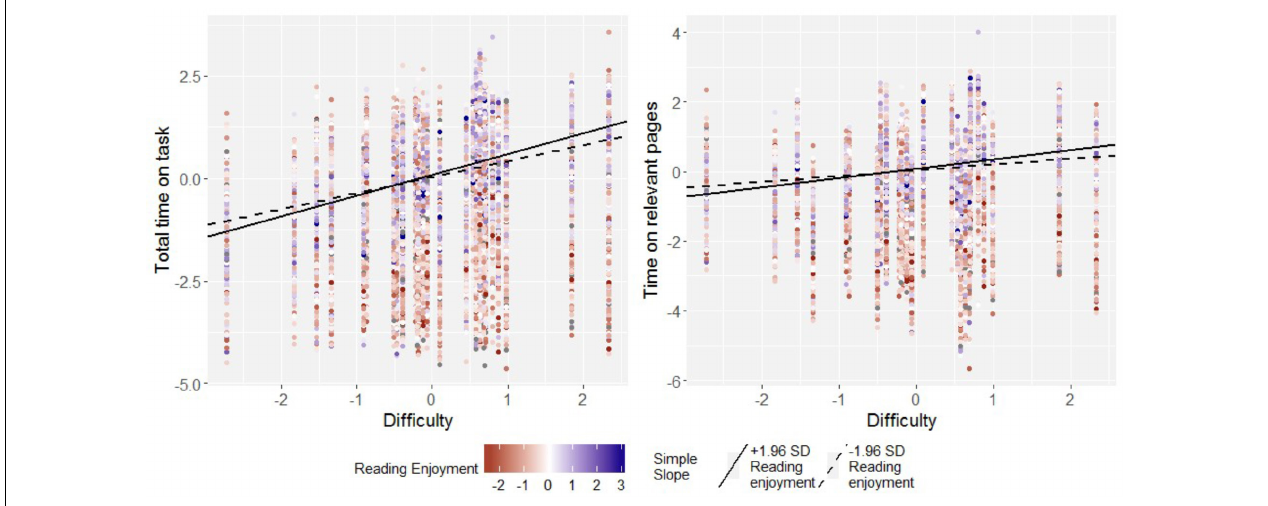
FIGURE 6 | Simple slopes for the regression of total time on task and time on relevant pages on task difficulty in students high (97.5th perc.) and low (2.5th perc.) in enjoyment of reading for one sample country (Australia). Data points are raw data. Regression intercepts and slopes are model-based